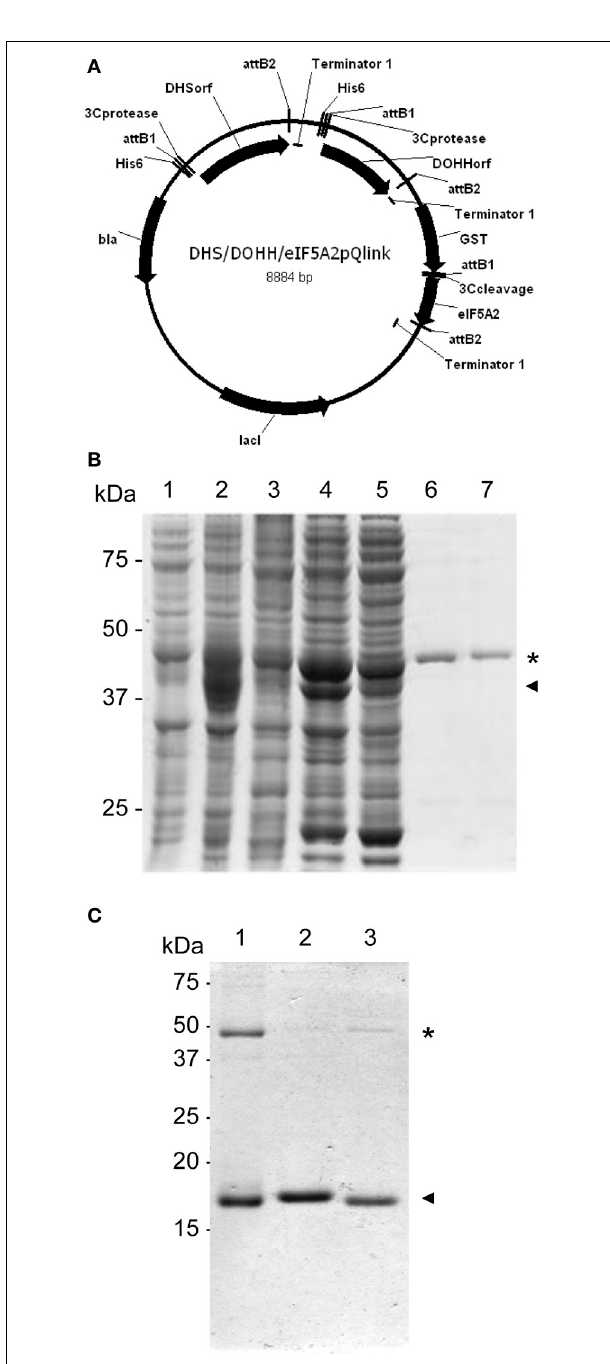
FIGURE 2 | Coexpression of GST-eIF5A proteins and hypusination enzymes. (A) Schematic diagram of the resulting plasmid after LIC cloning into pQlink of GST-eIF5A2 together with His-DHS and His-DOHH . (B) SDS-PAGE analysis of protein fractions for purification of hypusinated GST-eIF5A2. The coomassie staining SDS-PAGE contains in lane 1 a total non-induced protein extract, lane 2 IPTG-induced total protein extract, lane 3 non-induced total soluble protein extract, lane 4 IPTG-induced soluble protein extract, lane 5 unbound protein extract to glutathione sepharose, lanes 6 and 7 soluble protein extract after elution by glutathione competition. Asterisk indicates the presence of GST-eIF5A2 (45kDa) partially overlapping with His-DHS (44kDa), and arrowhead corresponds to